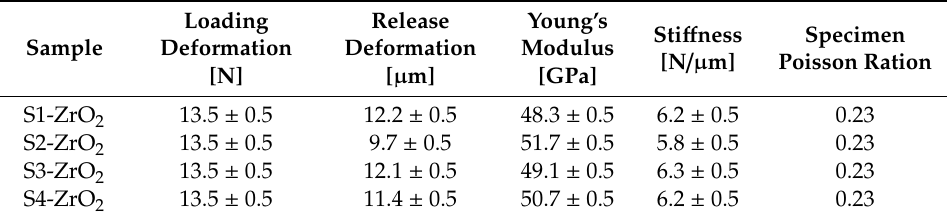
Table 5. Micro-indentation results.